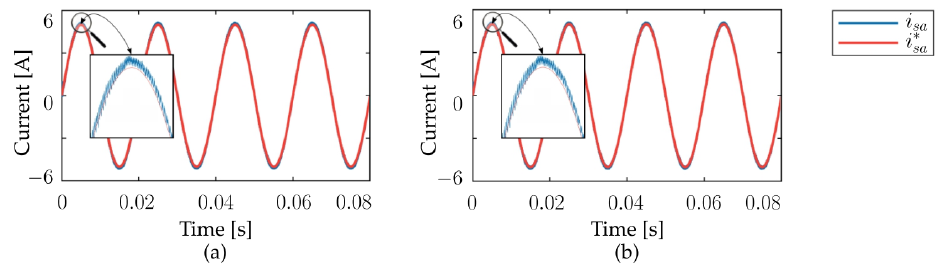
Figure 7. Results obtained from the variation of the parameter L m . ( a ) L m = 230 mH. ( b ) L m = 630